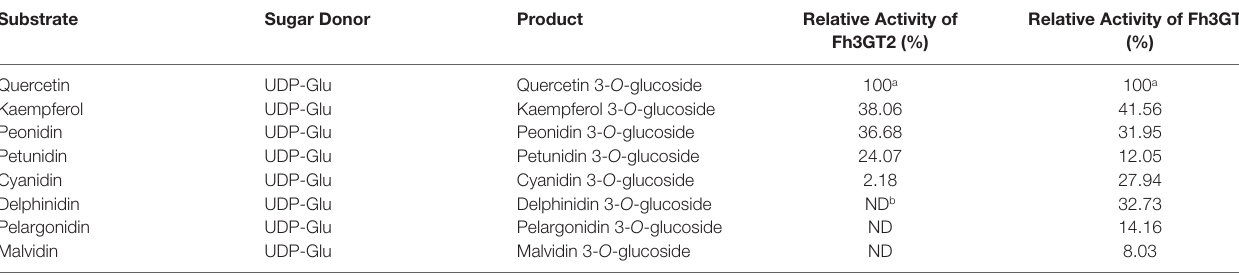
TABLE 1 | Relative activities of Fh3GT2 and Fh3GT1 towards several substrates.